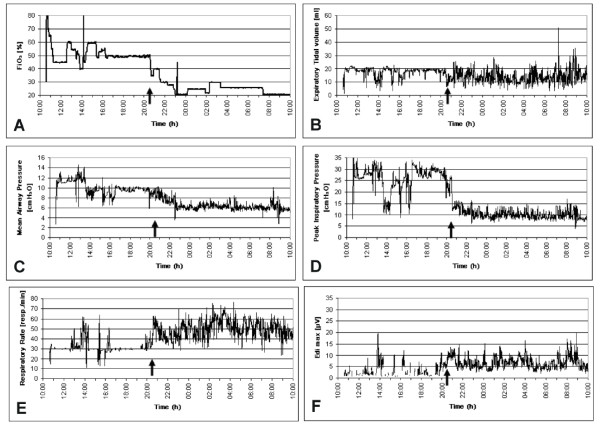
Continuous recording of ventilatory parameters for 24 hours (case 1). Figure demonstrates in the first patient the 24-hour evolution of FiO2 (Panel A), expiratory tidal volume (Panel B), mean airway pressure (Panel C), peak inspiratory pressure (Panel D), respiratory rate (Panel E) and Edi max (Panel F). The upward vertical arrows indicate the time point where the ventilator mode was switched from SIMV over to NAVA. (A first brief NAVA period was tested at 14:00). Upper panels: After starting NAVA, (A) FiO2 gradually decreased to 21% in 12 hours, and (B) tidal volume became much more variable from one cycle to another. Middle panels: One of the most remarkable changes observed with switching to the NAVA mode was the immediate reduction in the mean airway pressure (C) and in the peak airway pressure (D) which decreased from 30 to 10 cm H2O. Bottom panels: After starting NAVA, the respiratory rate became very variable over time (E). From a mandatory frequency set at 30 breaths per minute, respiratory rate increased to 40 and 60 breaths per minute. Clinically, the breathing became easier with harmonious chest movements. (F) Edi max that it is the sum of inspiratory Edi and Edi min corresponds to the peak of electrical activity of the diaphragm. In SIMV, this activity is depressed, and in NAVA, the inspiratory Edi (Edi max - Edi min) drives ventilation. Abbreviations: FiO2, fraction of inspired oxygen; Edi, electrical activity of the diaphragm; SIMV, synchronized intermittent mandatory ventilation.